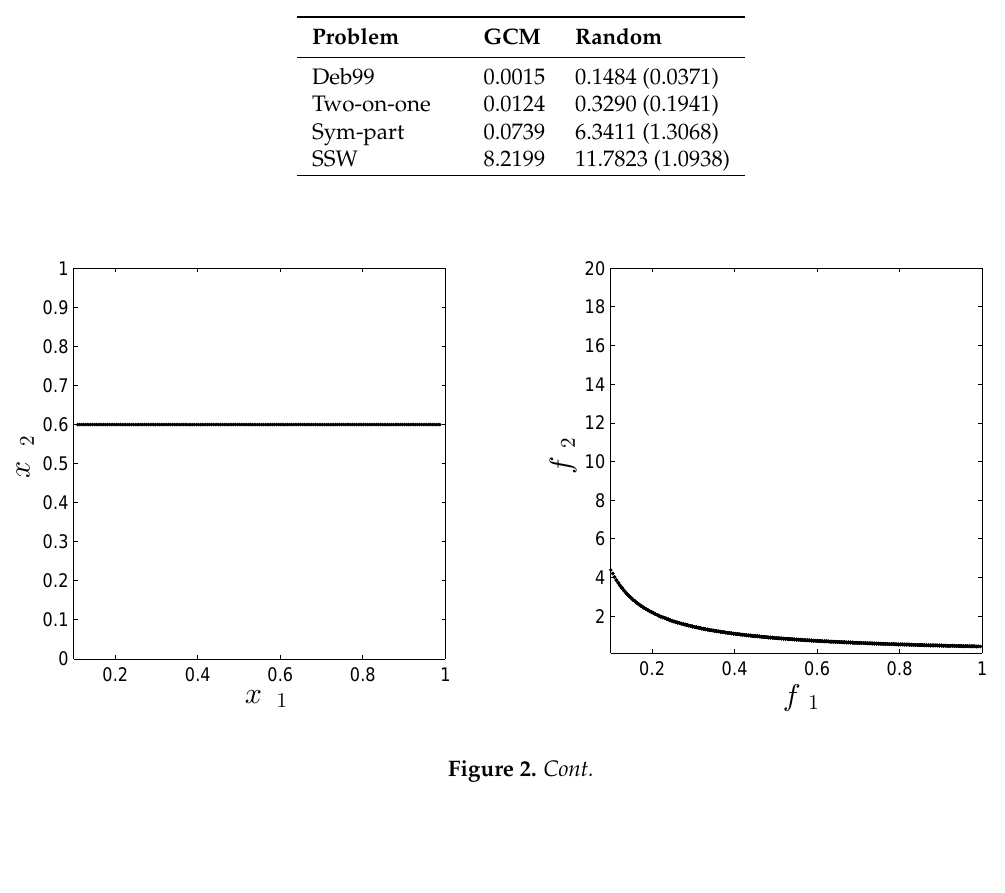
Table 3. ∆ 2 values and GCM and archiver for each problem.